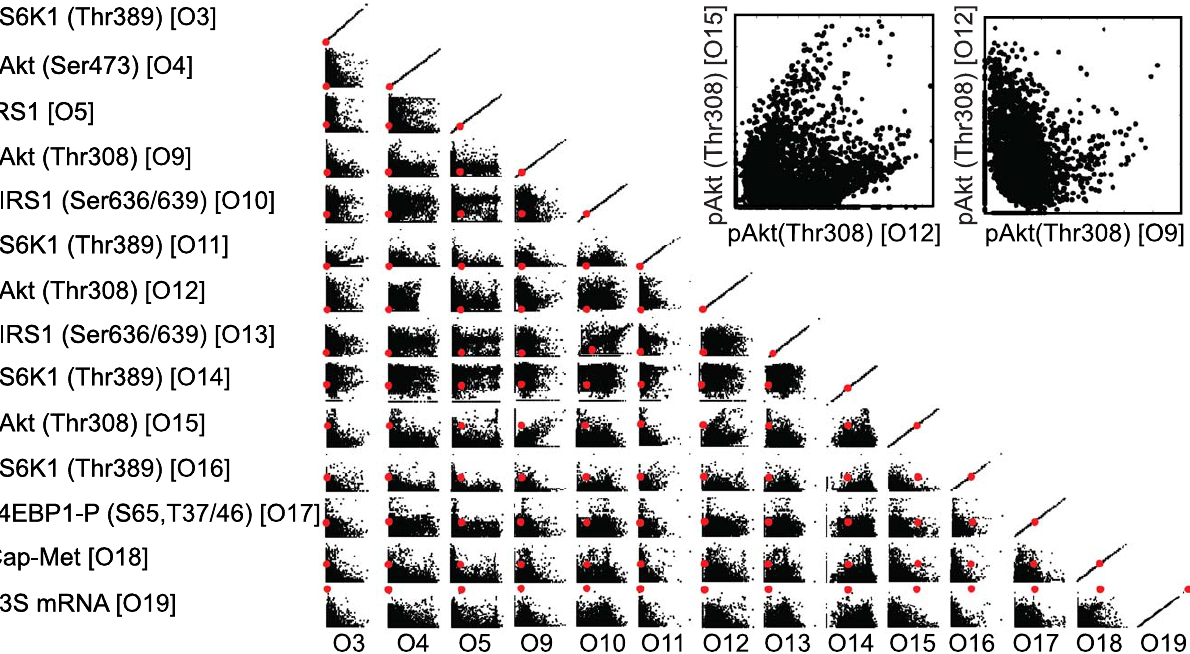
Figure 2. The scaled simulation error (SSE) for selected objective function pairs for N=5818 rank zero initiation models. The SSEs for objective functions chosen by cross-validation for prediction was set to zero and disregarded when ranking other sets. The red point denotes the performance of the nominal parameter set.